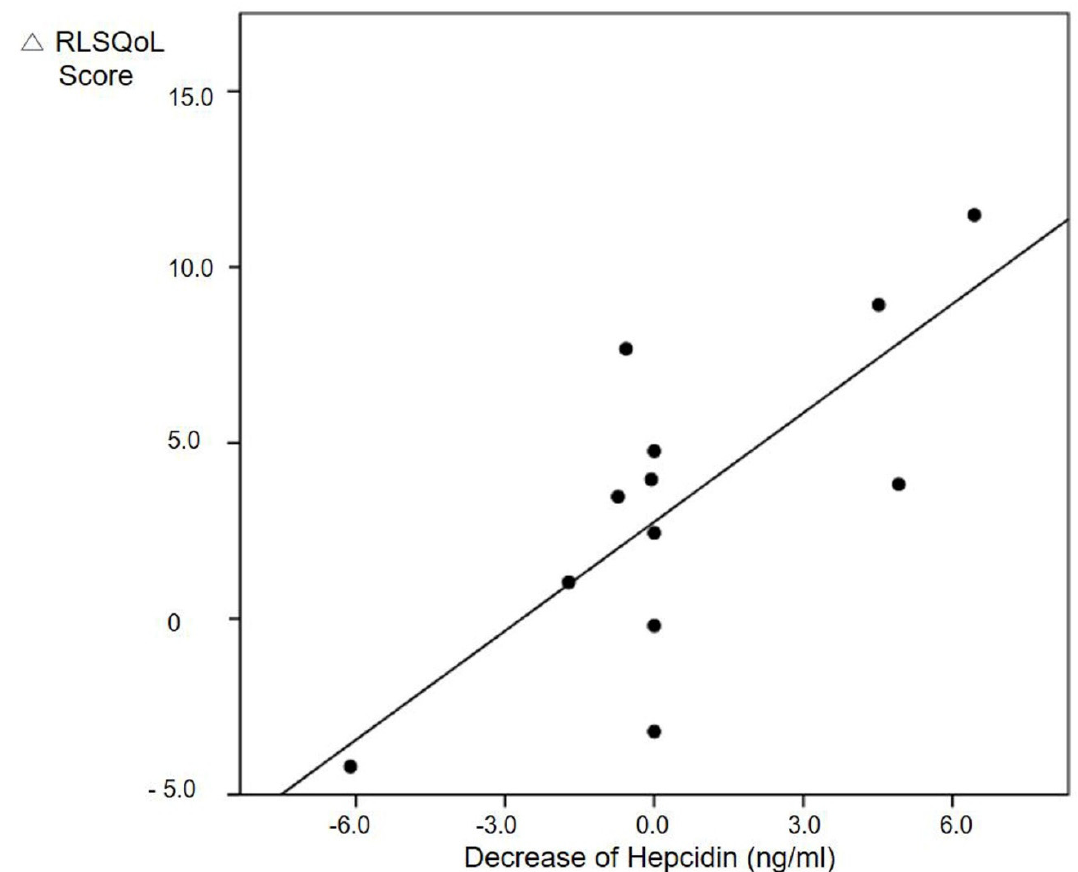
Figure 1. Linear association between improvement of quality of life and decrease of hepcidin in RLS patients 12 weeks after treatment. Abbreviations: RLS, restless legs syndrome; RLSQoL, Restless Legs Syndrome Quality of Life score.